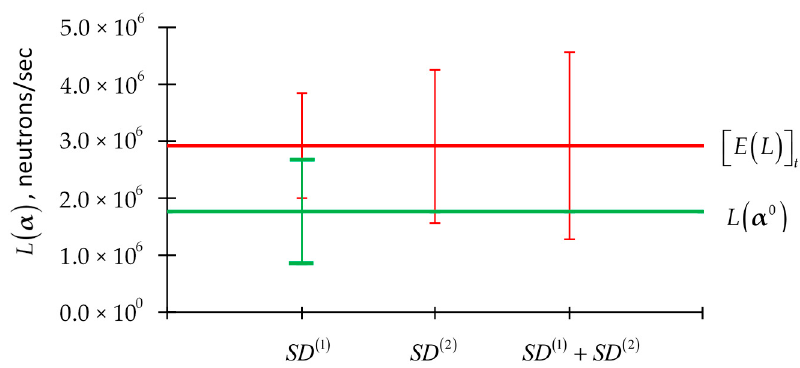
(cid:16) (cid:17) ) ( ) ± SD ( 1 ) (in green), [ E ( L )] ± SD ( 1 ) , SD ( 2 ) , SD ( 1 ) + SD ( 2 ) (in red), due α 0 Figure 12. Comparison of L ± 10 L SD α (in green), (in red), Figure 12. Comparison of t to 5% standard deviations of the uncorrelated total microscopic cross due to 5% standard deviations of the uncorrelated total microscopic cross sections.